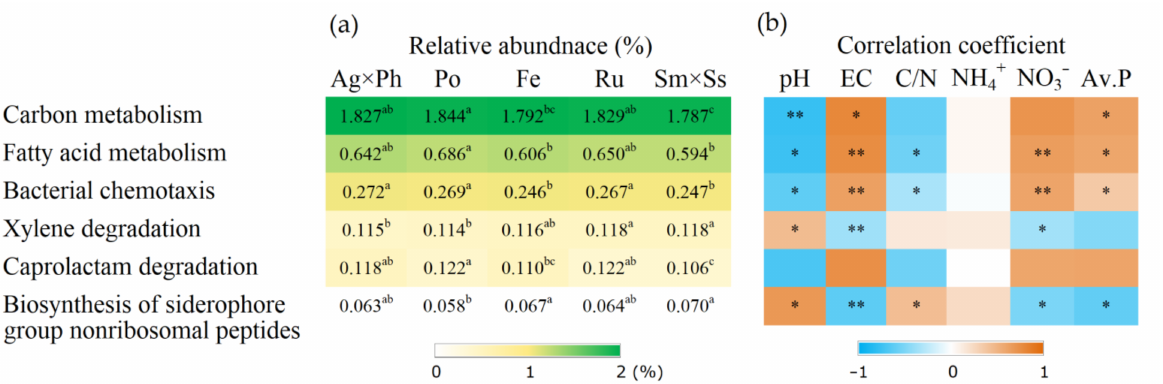
Figure 7. Putative functions of soil bacteria showed significant difference according to FAPROTAX and their correla- tion with soil chemical properties. ( a ) Relative abundance of bacteria; ( b ) Spearman’s correlation coefficient. Ag × Ph, A. alba × P. pratense ; Po, P. pratensis ; Fe, F. ovina ; Ru, R. acetosella ; Sm × Ss, S. miyabei × S. salicifolia . Different letters in the same row indicate significant differences according to Tukey test (n = 3, p < 0.05). *, **, and *** indicate significant correlation at p < 0.05, p < 0.01 and p < 0.001, respectively.